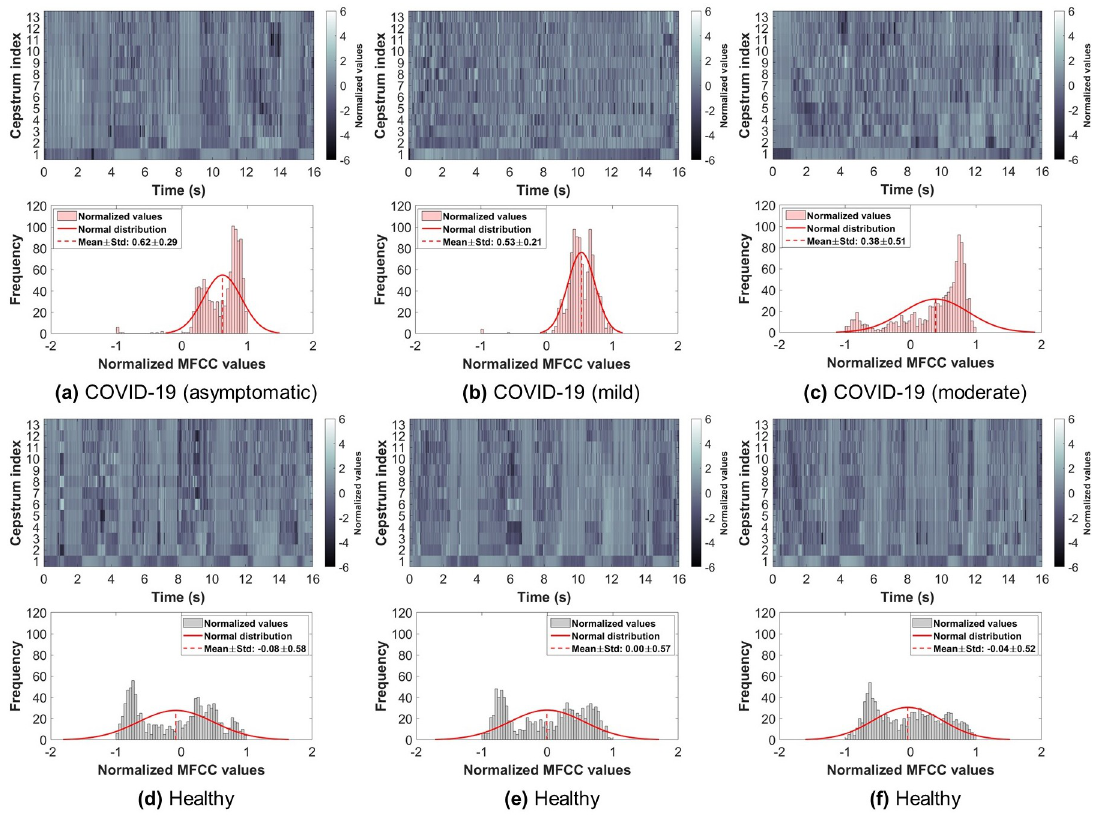
Fig 5. Examples of the mel-frequency cepstral coefficients (MFCC) extracted from the shallow breathing dataset and illustrated as a normal distribution of summed coefficients. Showing: (a-c) COVID-19 subjects (asymptomatic, mild, moderate), (d-f) healthy subjects.